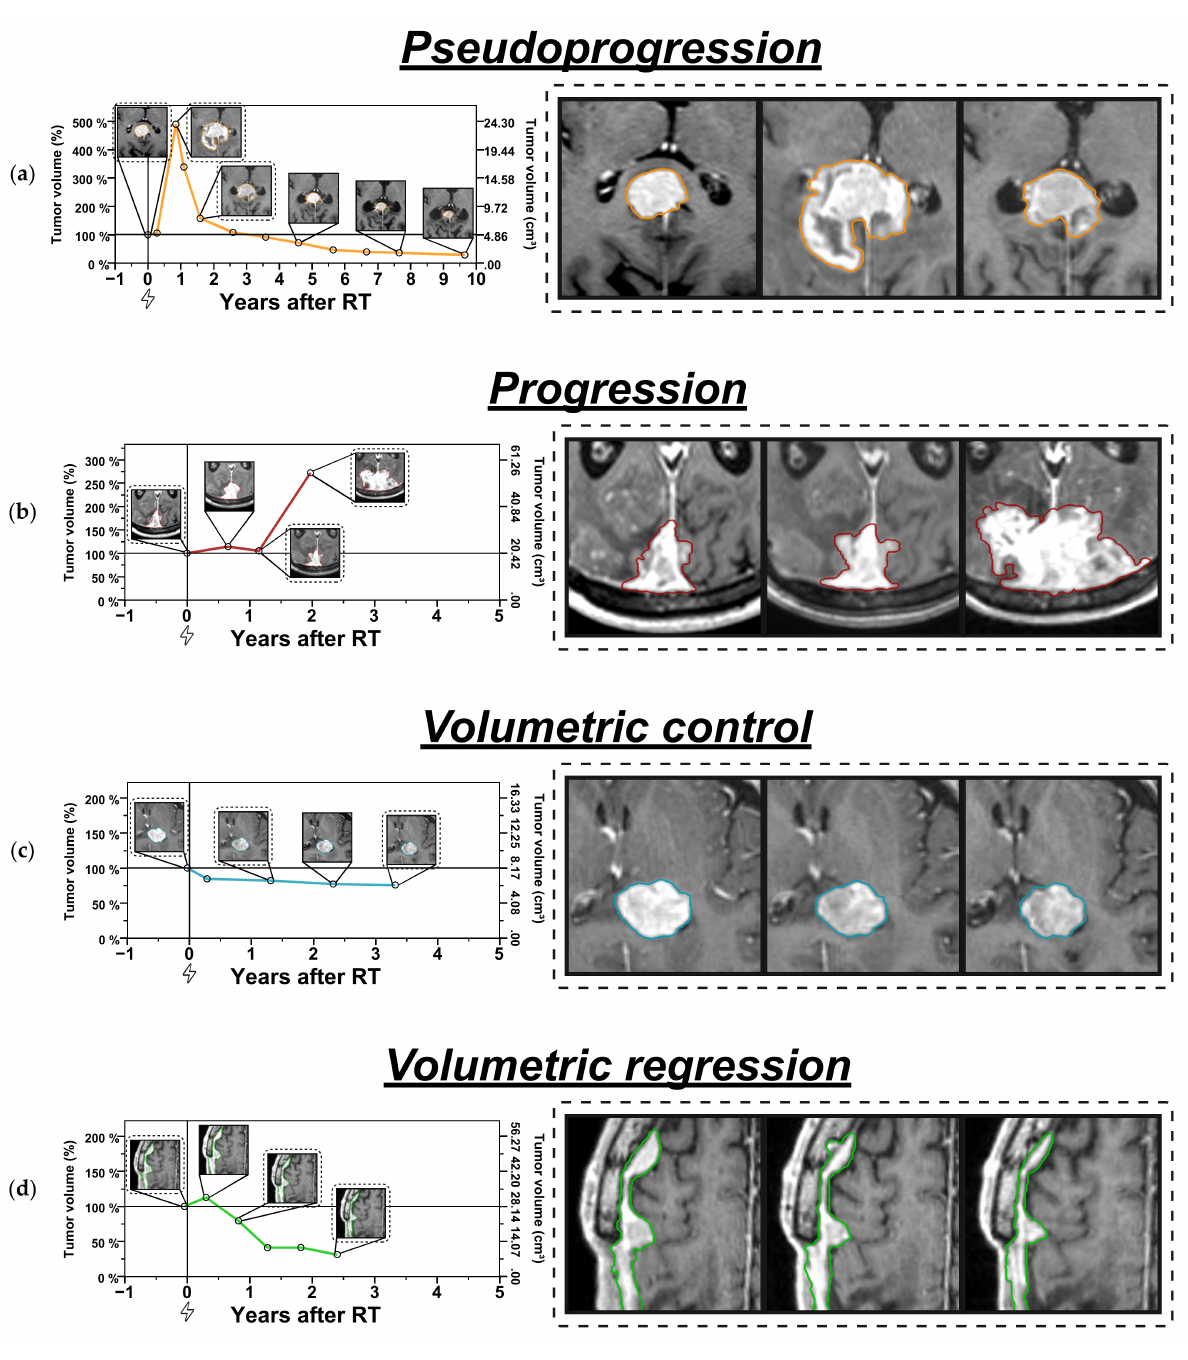
Figure 2. ( a ) Individual examples of pseudoprogression/transient enlargement, ( b ) progression, ( c ) volumetric control and ( d ) volumetric regression. Graphs on the left side: meningioma volumes are expressed relative to baseline volume (left y-axis) over time with the right y-axis showing the absolute tumor volume in cm 3 . The flash symbol indicates the time of radiotherapy (0 months— 100% relative tumor volume). Inlay images show tumor segmentations for different measurement time points. Images on the right side: enlarged view of selected segmentations highlighted in the corresponding left-hand graph. Scale bar or